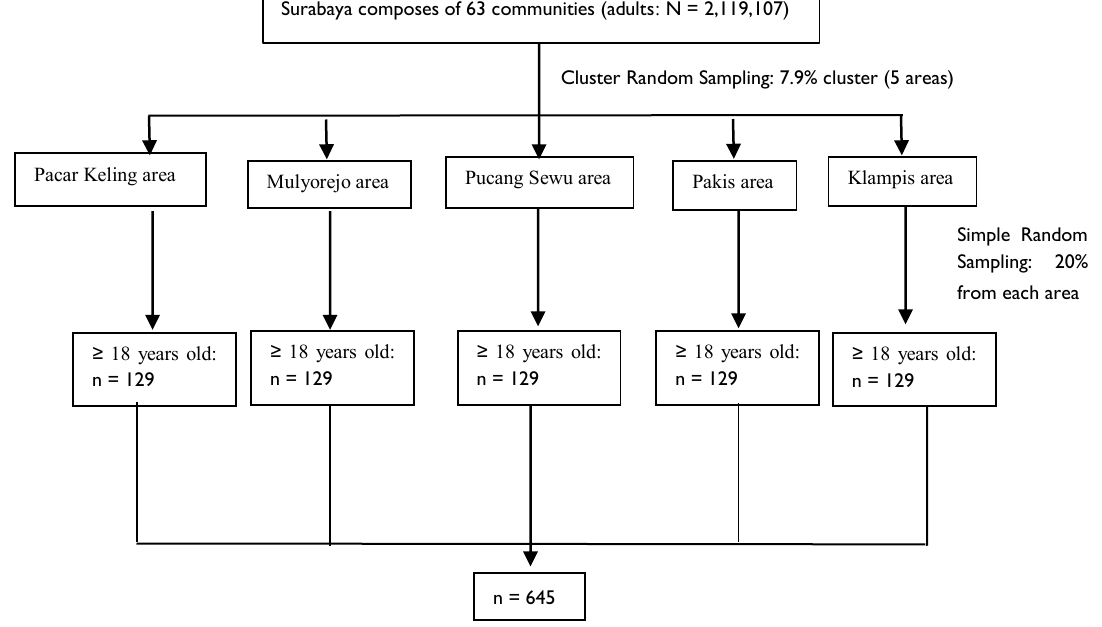
Figure 1. Study sites and sample selection